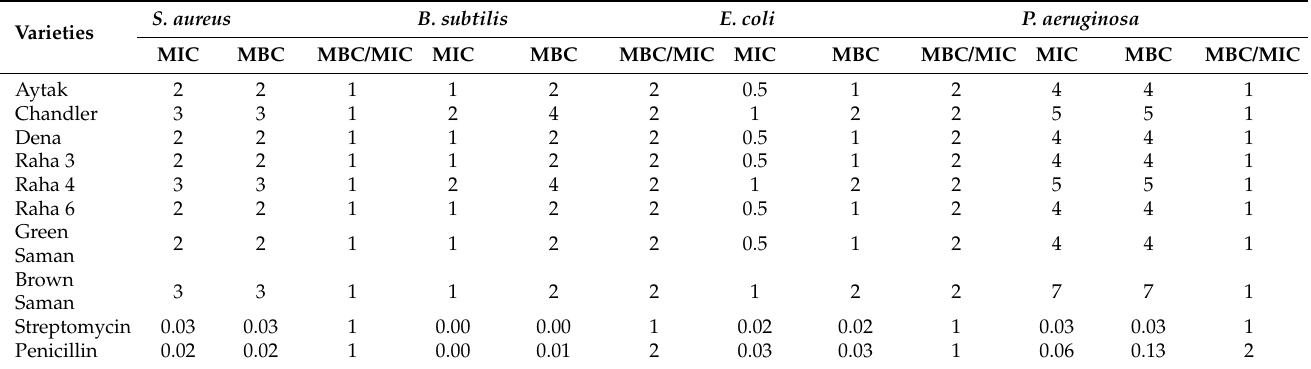
Table 4. Antibacterial properties (MIC (mg/mL), MBC (mg/mL), MBC/MIC (-)) of various varieties of walnut husk extracts against S.aureus , B. subtilis , E. coli , and P. aeruginosa collection ( n =